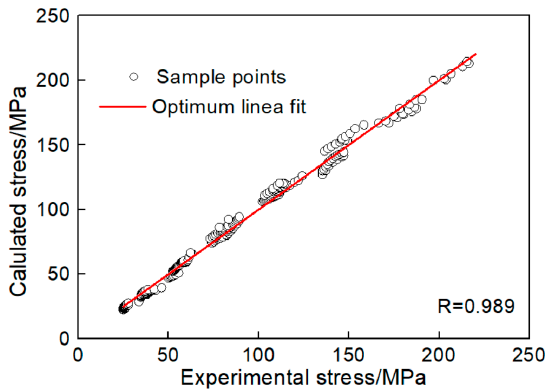
Figure 13. Correlation between the experimental value and calculated value.